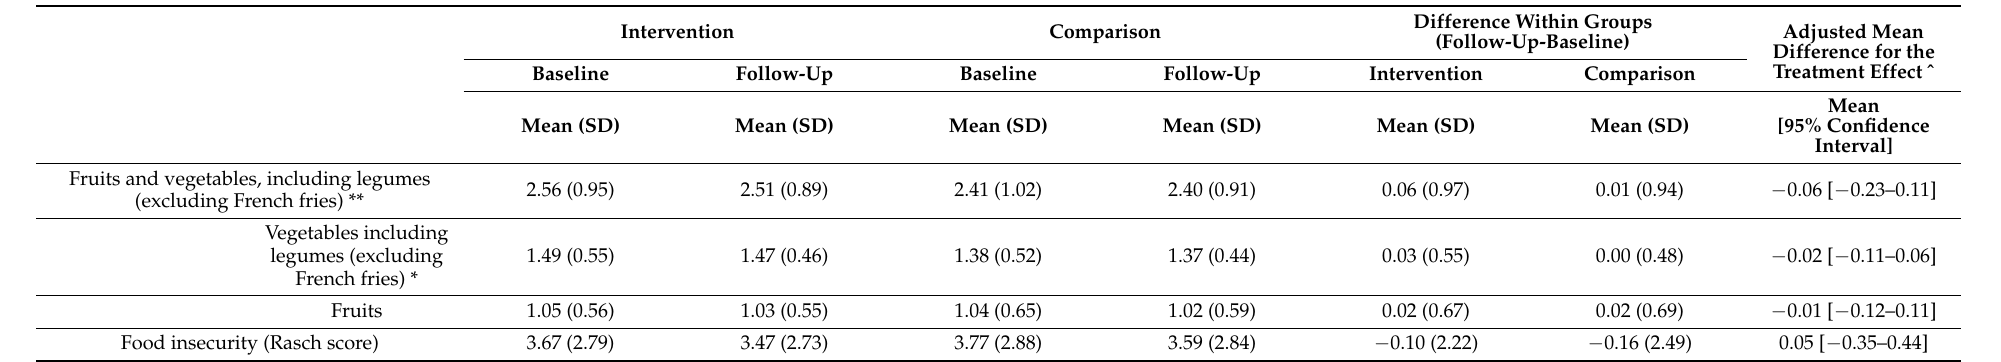
Table 2. Mean changes in Rasch food security scores and of daily intake of fruits and vegetables (cup equivalents): intervention and comparison groups. Intervention Comparison Difference Within Groups